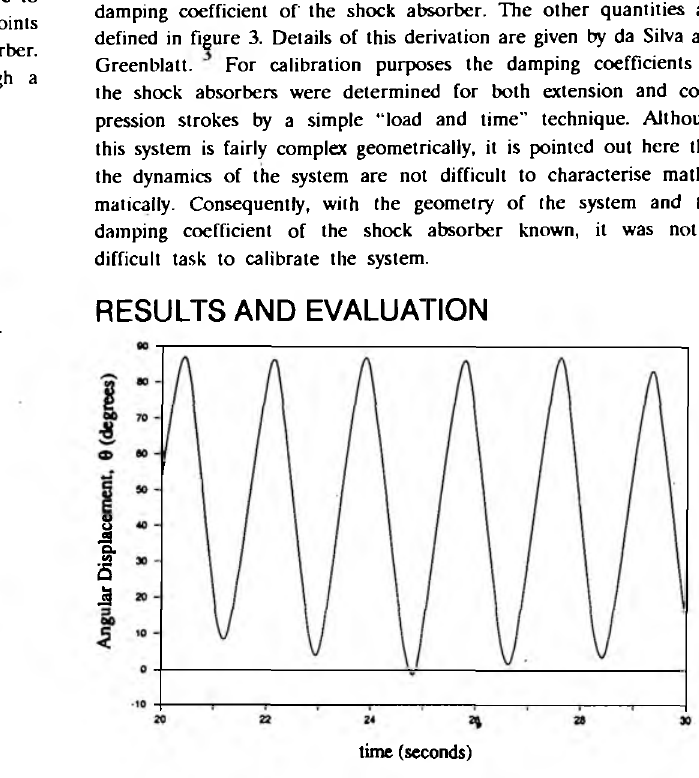
Fig 4: Angular displacement versus time plot for patient A - right